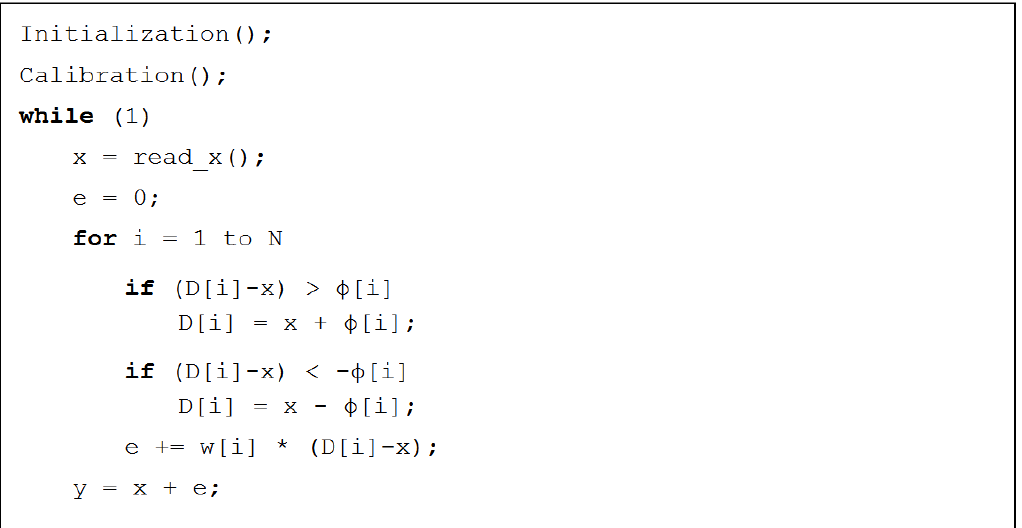
Figure 3. The pseudo code for modeling the sensor’s output using the Lagging-domain model. At each time step the true position of the sensor is read from the reference encoder. Then, the states of the domains are updated. The estimated error of the sensor is calculated. The estimated output of the sensor is the sum of the correct value and the estimated error.